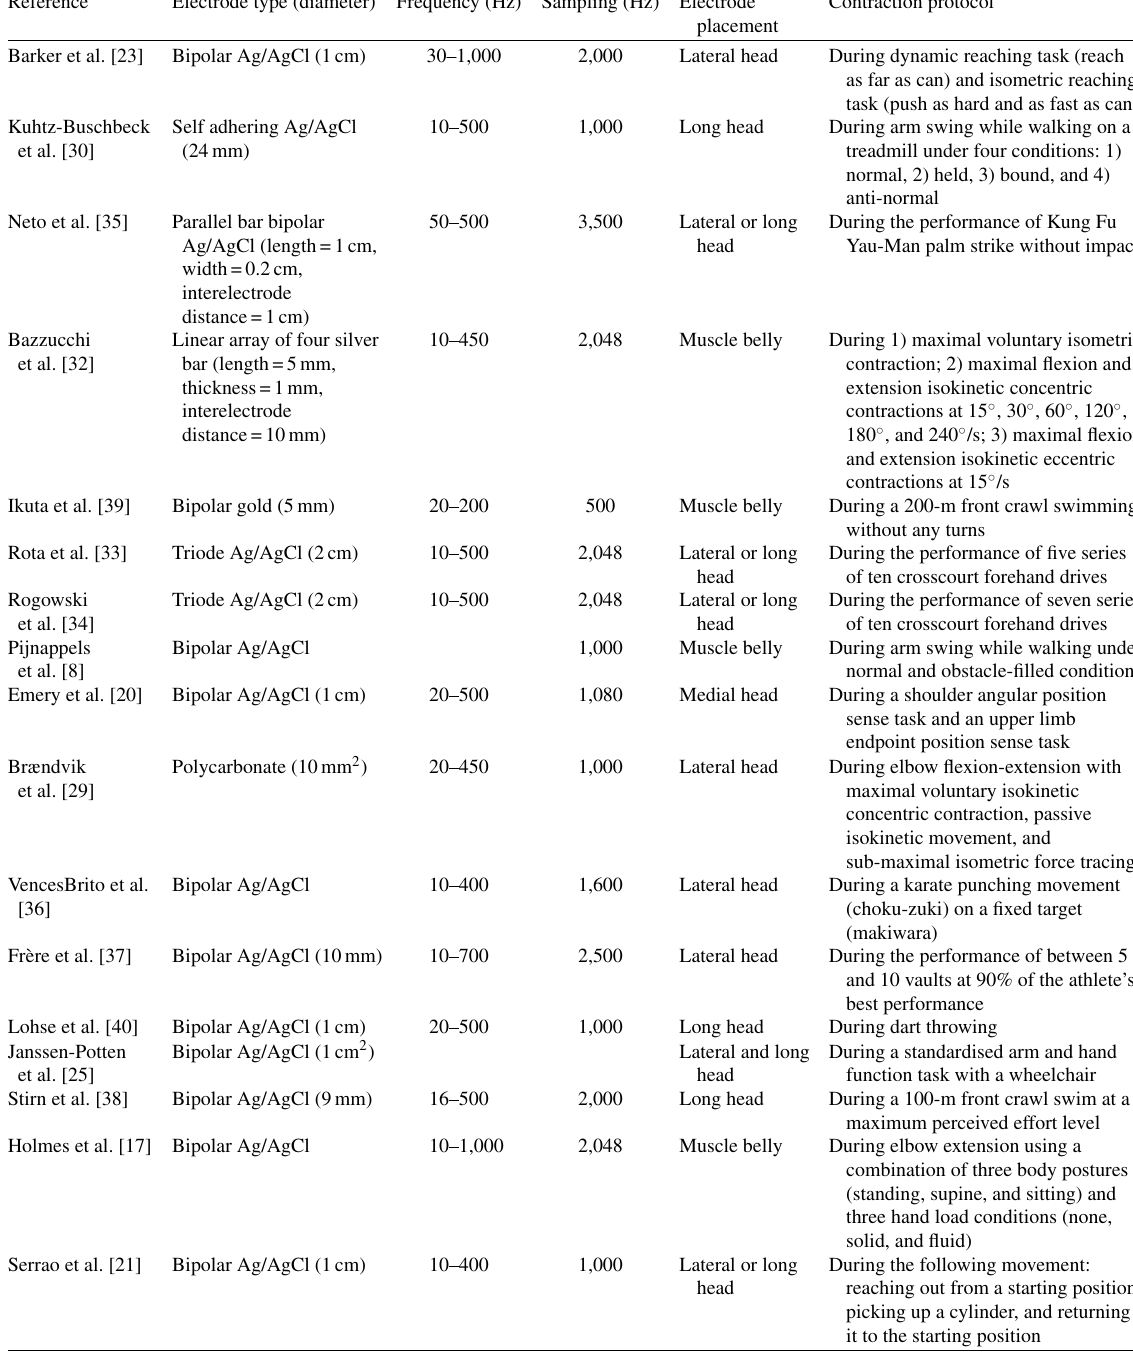
Table 1 Techniques and contraction protocols used for the sEMG recording of the TB